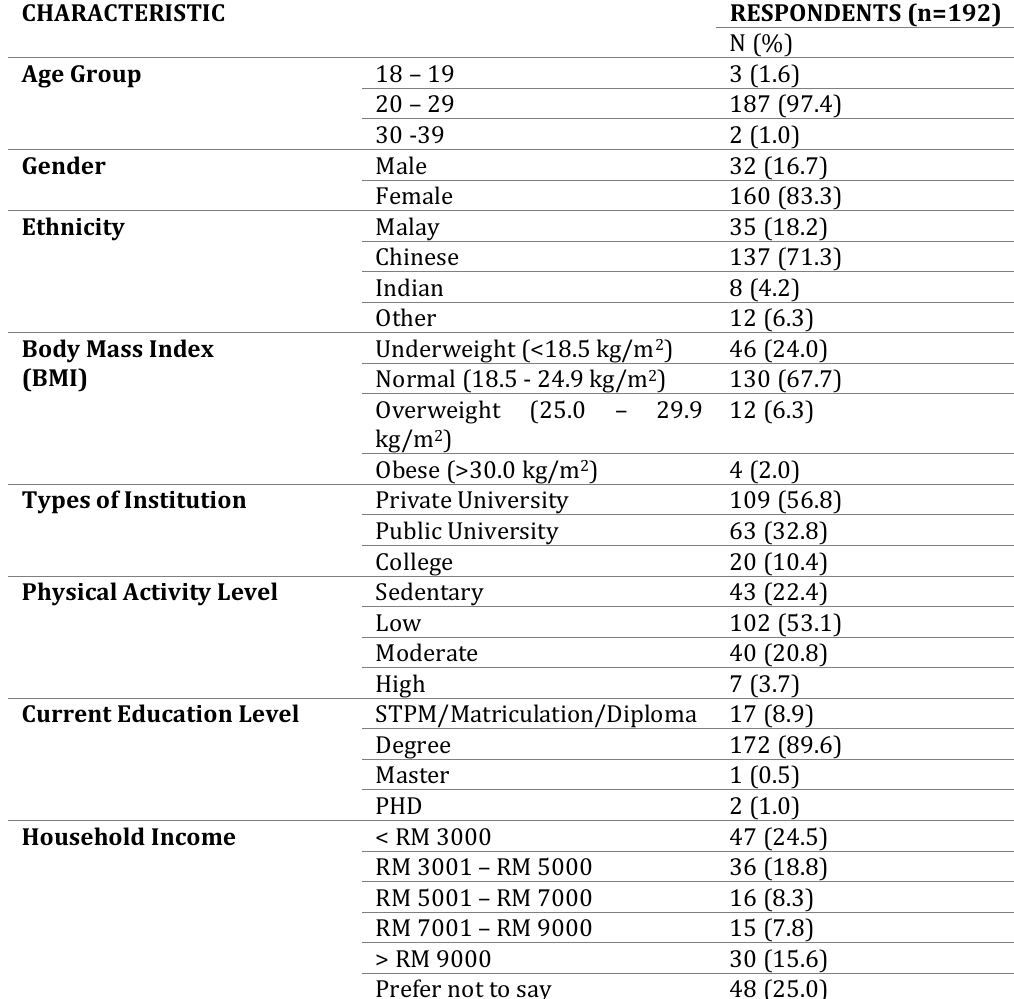
Table 4 : Personal characteristics of